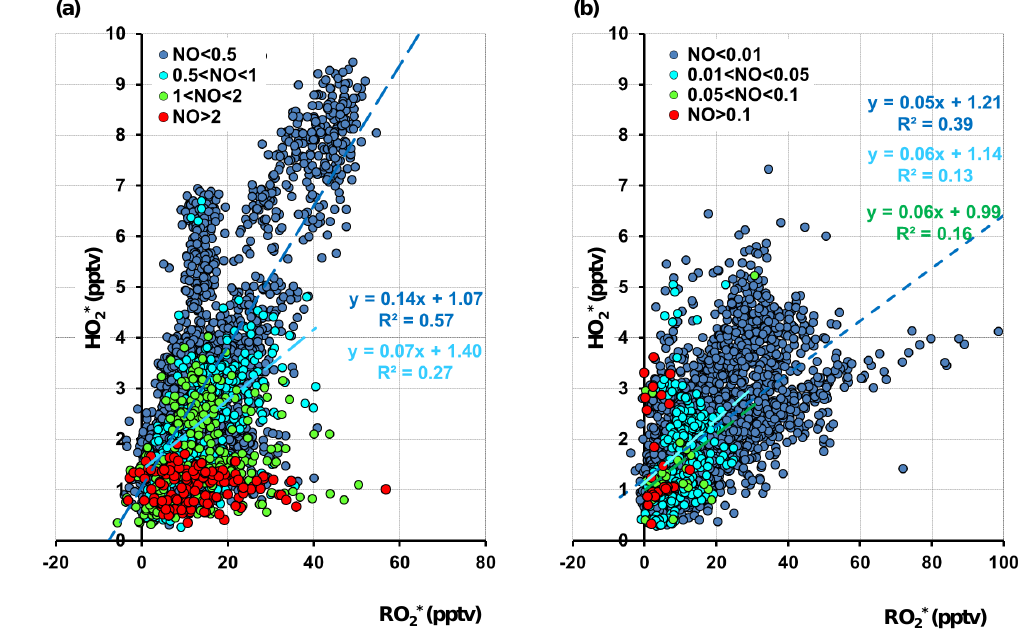
Fig. 12. HO ∗ versus RO ∗ for different NO mixing ratios (NO inppbv) measured during DOMINO. Data for (a) photochemical (06:00– 2 2